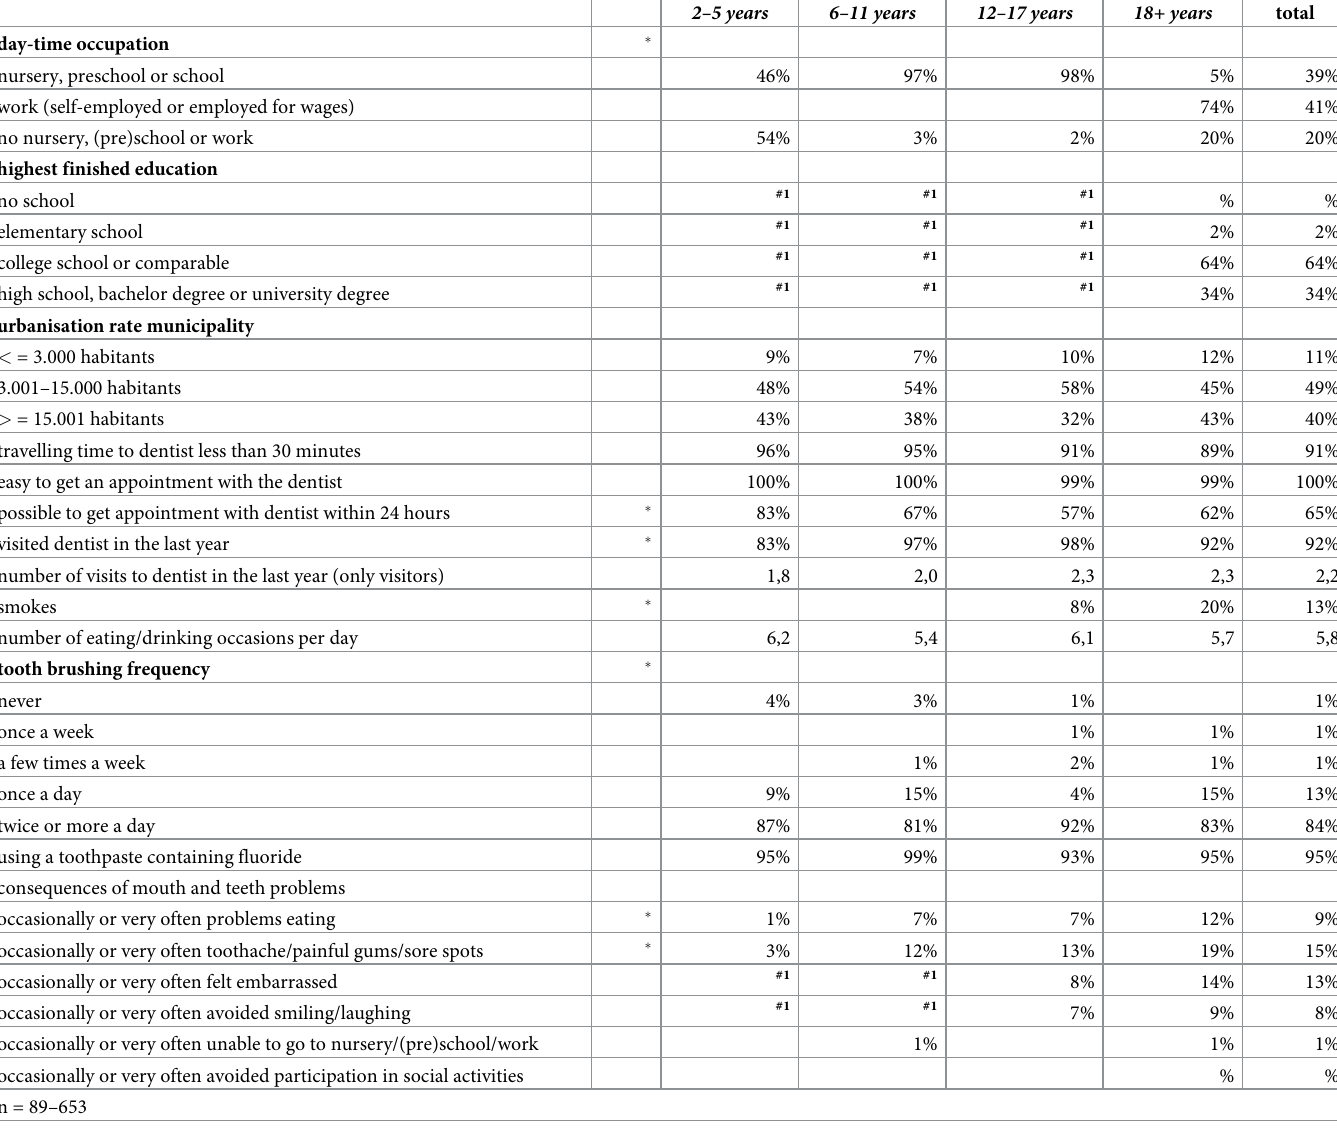
Table 4. Results of the OHO-questionnaire about background characteristics and oral health, provided by the